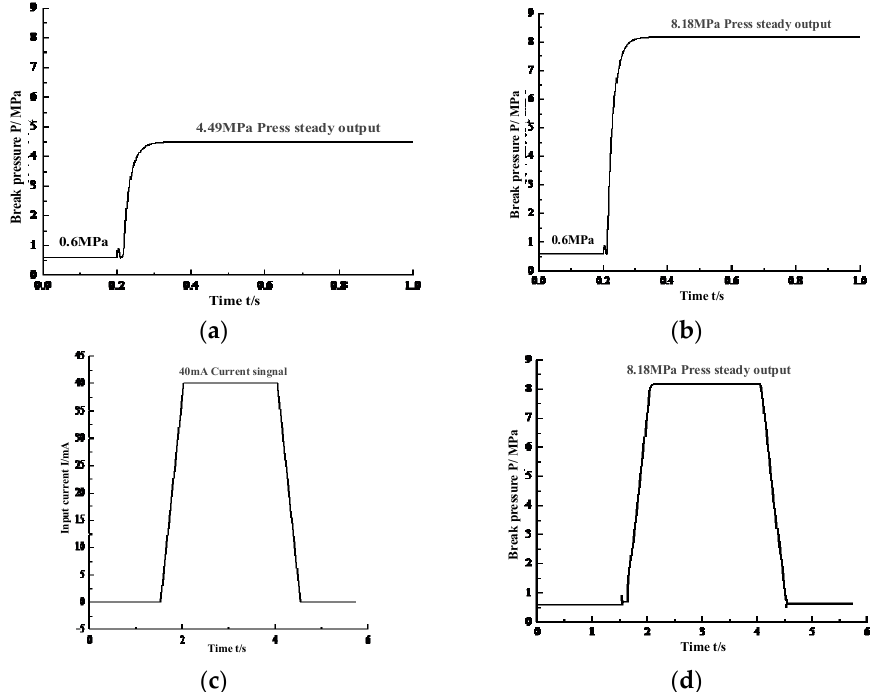
Figure 8. Simulation analysis of new brake pressure servo valve-actuator system. ( a ) 20 mA step brake pressure response. ( b ) 40 mA step brake pressure response. ( c ) 40 mA ramp input signal. ( d ) 40 mA ramp brake pressure response.